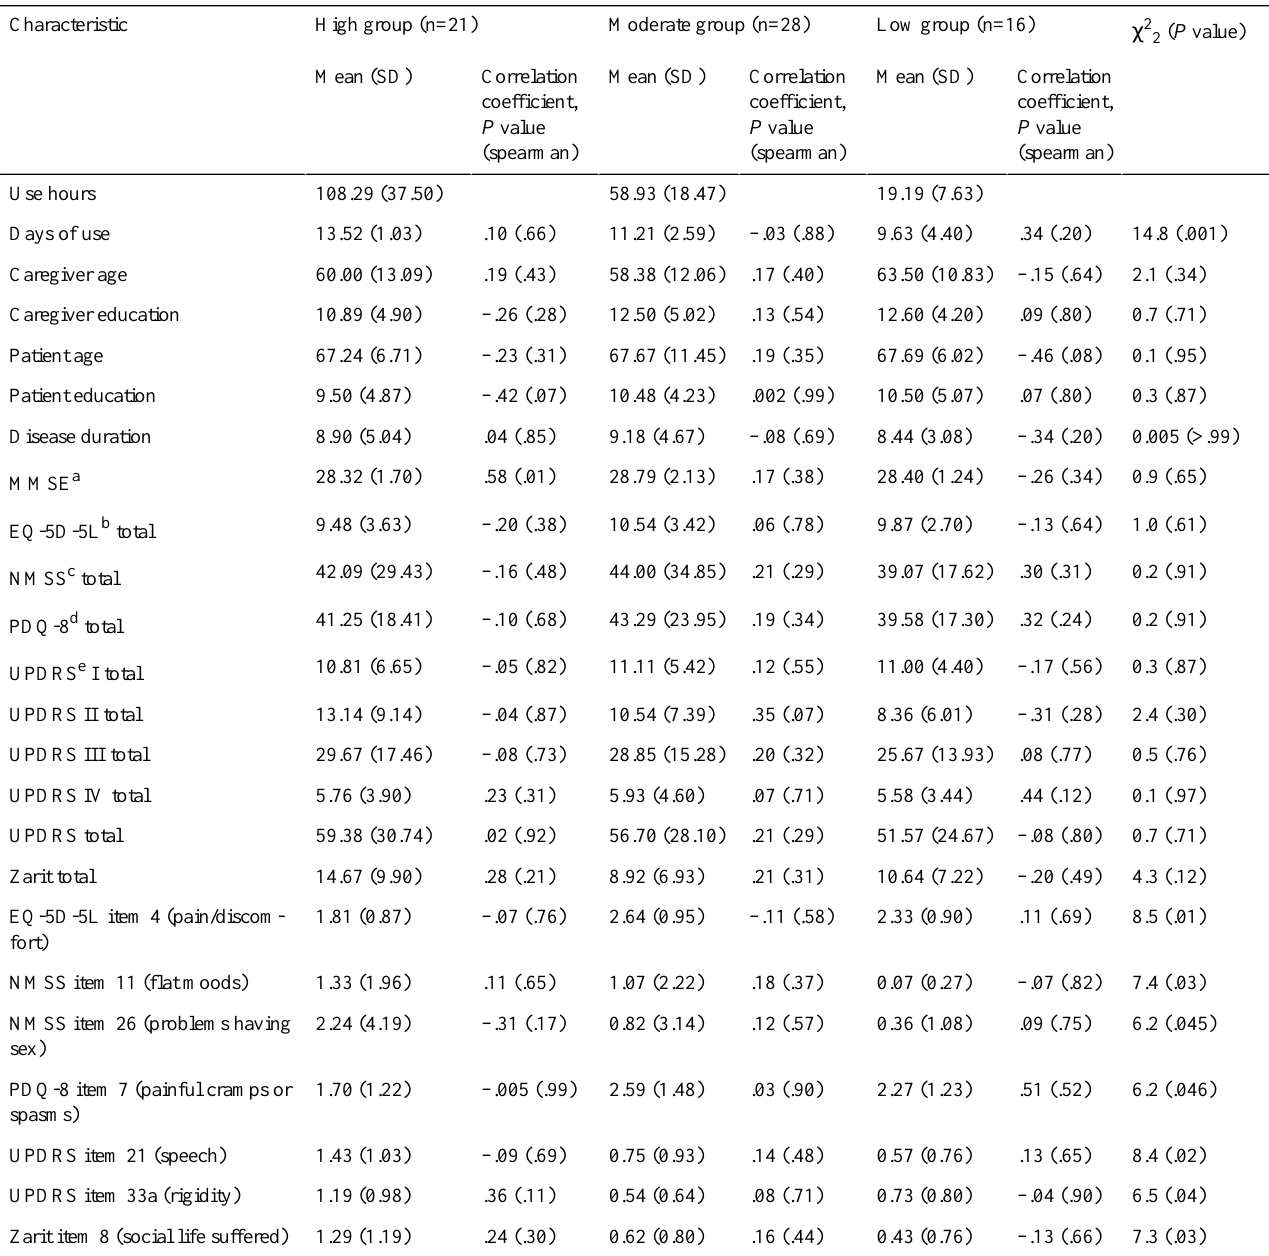
Table 3. Analysis of distributions between